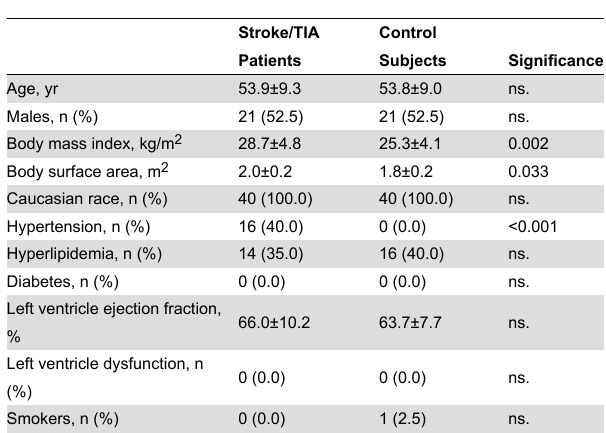
Table 1. Clinical Characteristics of 40 Patients with Acute Cryptogenic Stroke/TIA and 40 Age- and Gender-Matched Control Subjects.